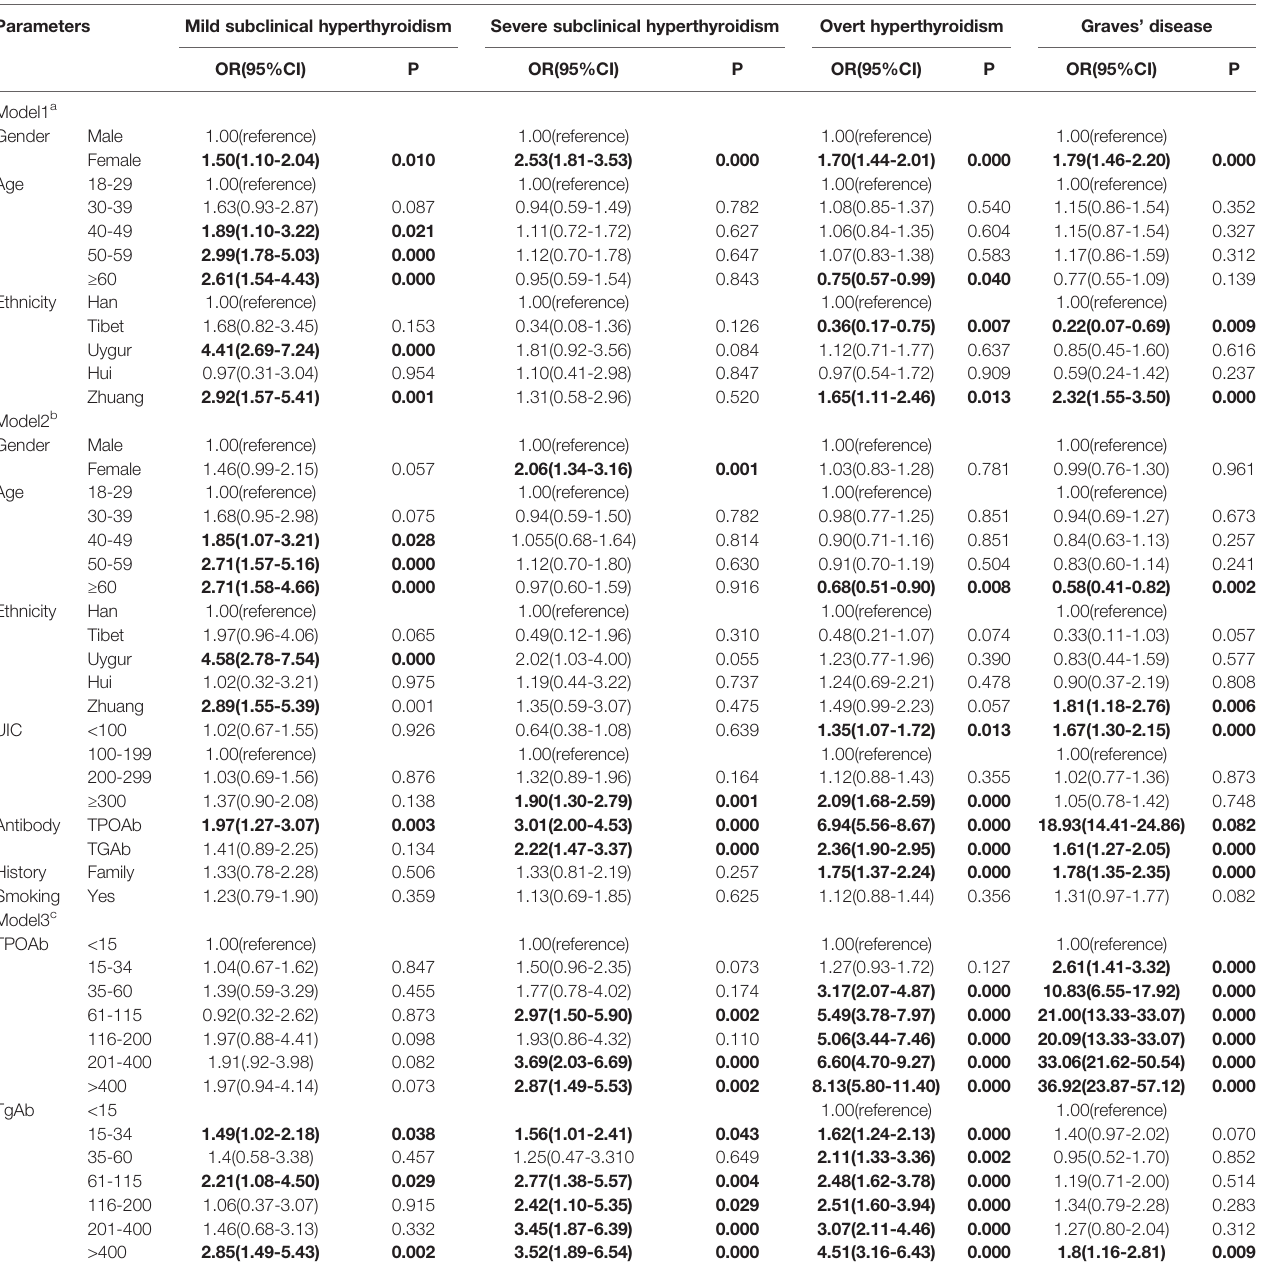
TABLE 3 | Logistic regression analysis of risk factors for hyperthyroidism and Graves ’